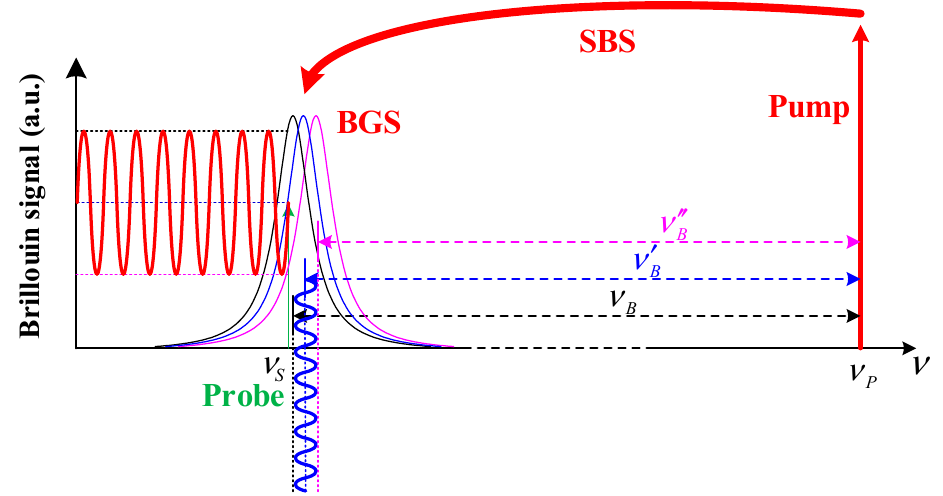
Figure 8. The sketch diagram of the SA-BOTDA [39]. The intensity of the Brillouin signal changes as the BFS changes.